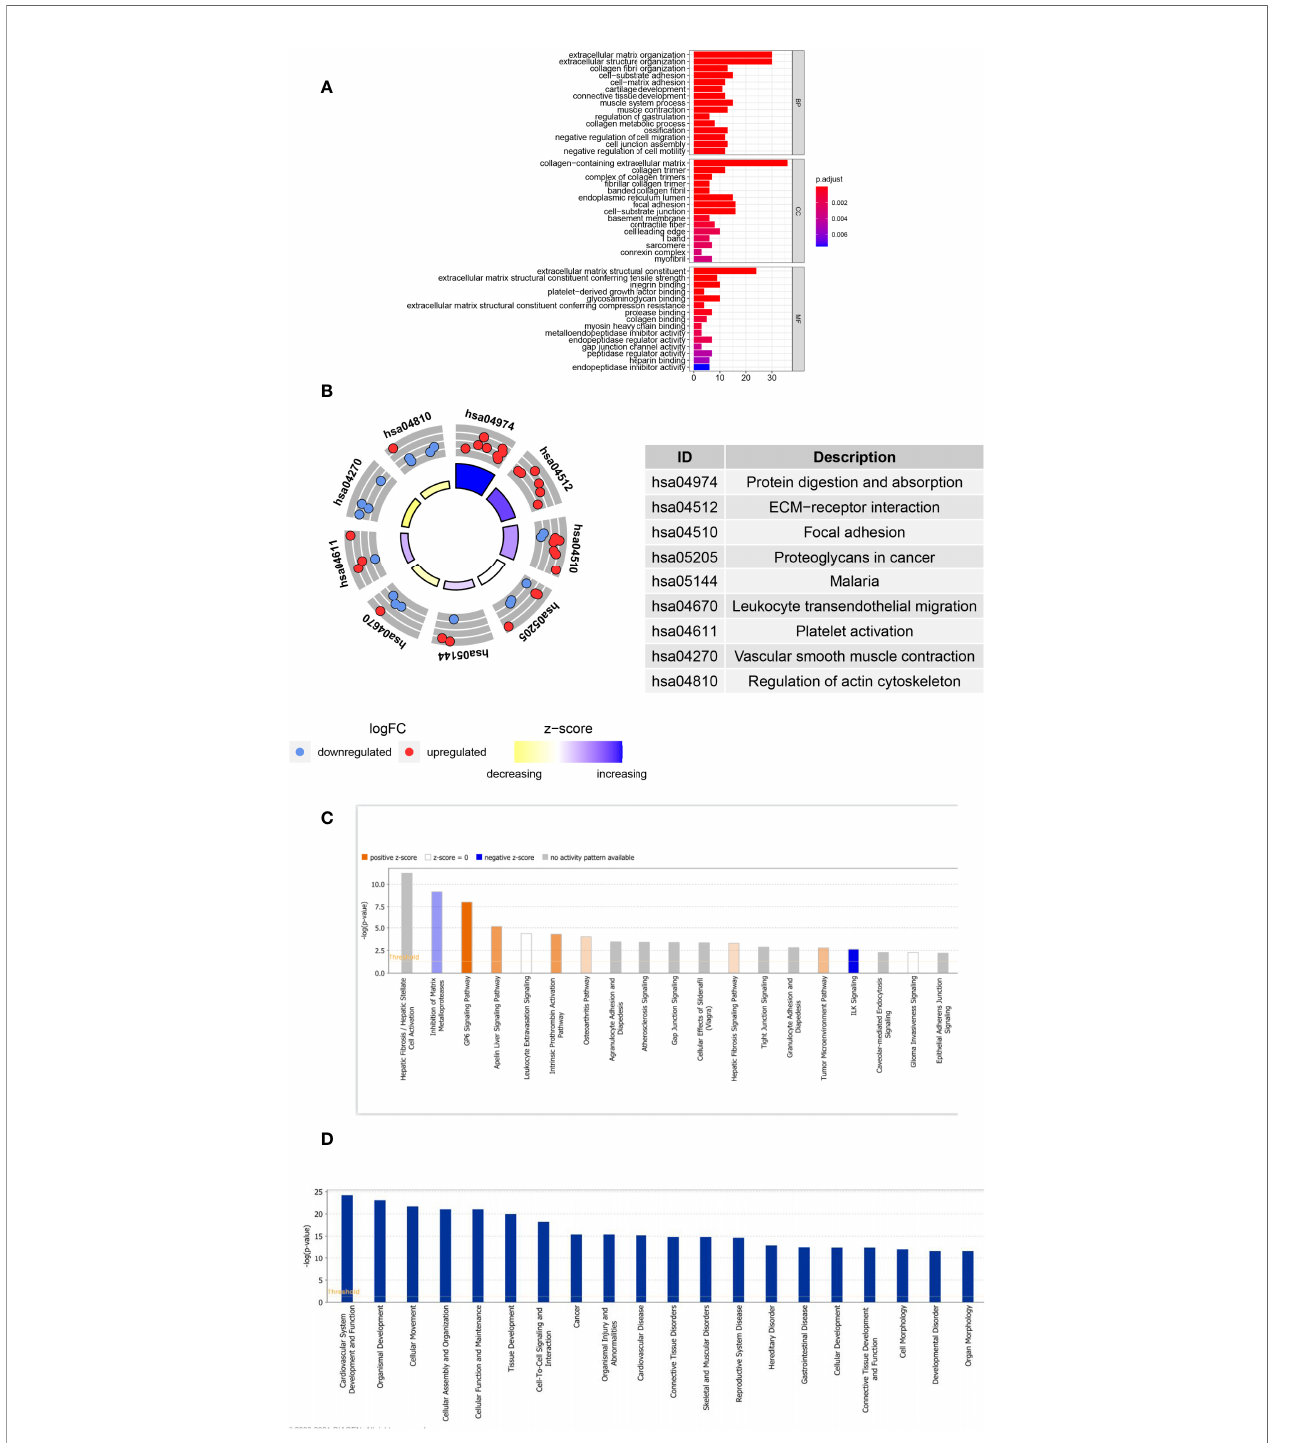
FIGURE 5 | Analyses of the Gene Ontology (GO) and Kyoto Encyclopedia of Genes and Genomes (KEGG) and Ingenuity Pathway Analysis of POSTN- related genes. (A) GO enrichment analysis. The horizontal axis indicates the number of target genes contained in the GO entry; the vertical axis indicates the name of the GO entry, and the color indicates -log10 P -value. (B) KEGG enrichment analysis. The z-score was calculated as the number of upregulated genes minus the number of downregulated genes divided by the square root of the number of genes in each pathway. (C) The classical pathways of POSTN-related genes were analyzed by IPA. Classical pathways involved a wide variety of signaling pathways, tumor microenvironment, and immune-related pathways. (D) Functional pathways of POSTN- related genes analyzed by IPA, which involved disorders of the cardiovascular system, disorders of the connective tissues, cell assembly, movement, and function and